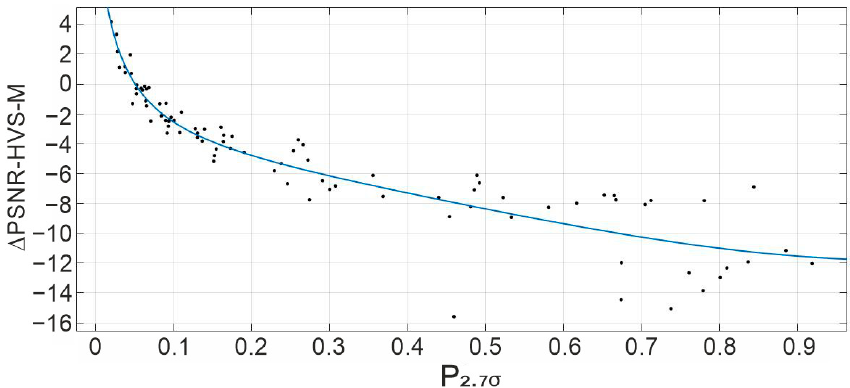
∆ PSNR − HVS − M vs. P 2.7 σ and the fitted